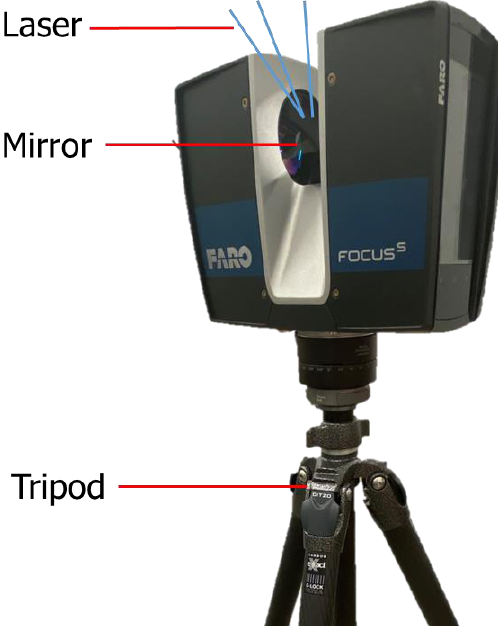
Figure 6. FARO Focus S 3D scanner.